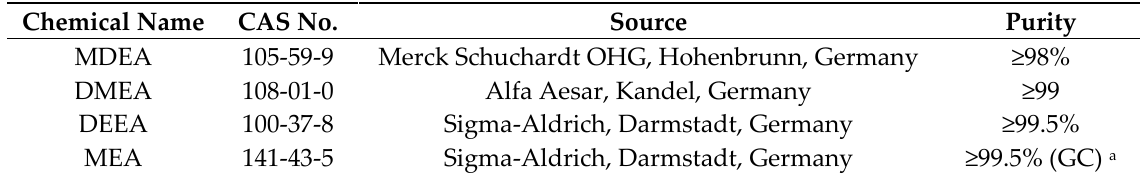
Table 1. Materials used in this